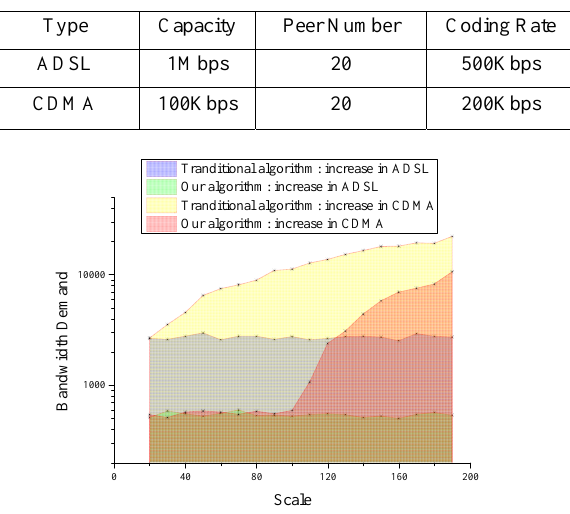
Figure 4. Bandwidth demand of video source